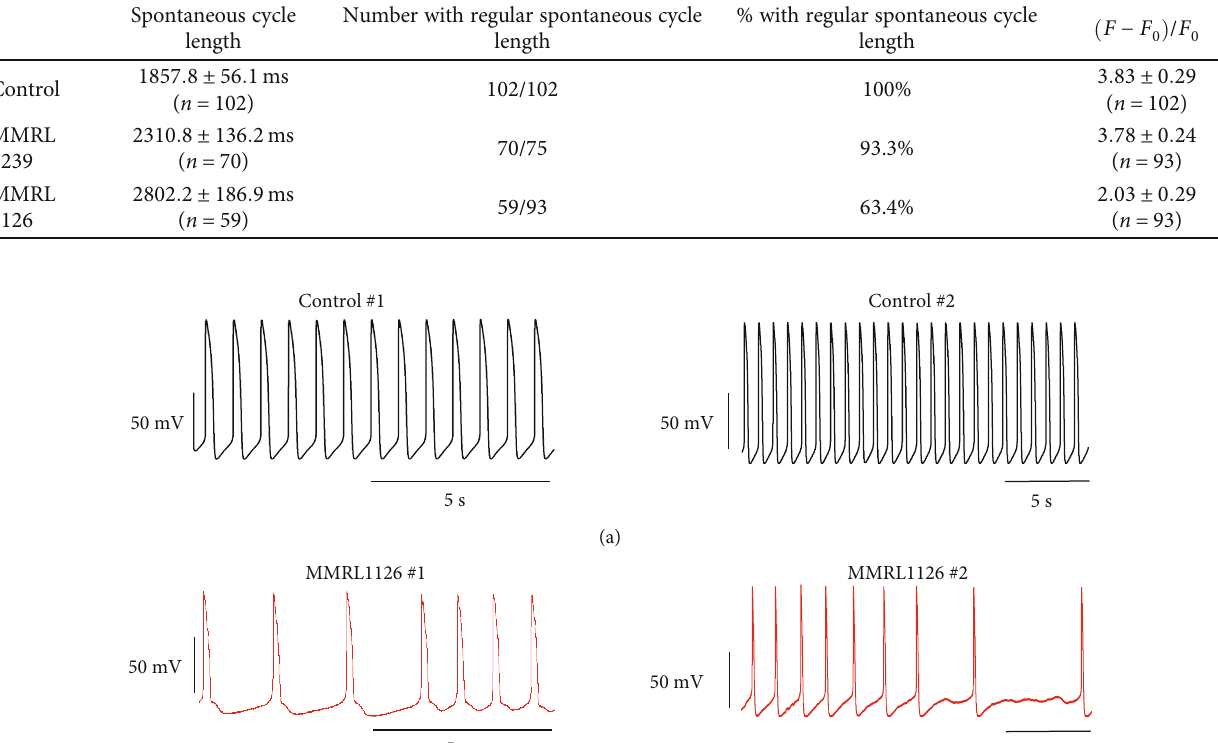
Table 2: Calcium transient parameters from